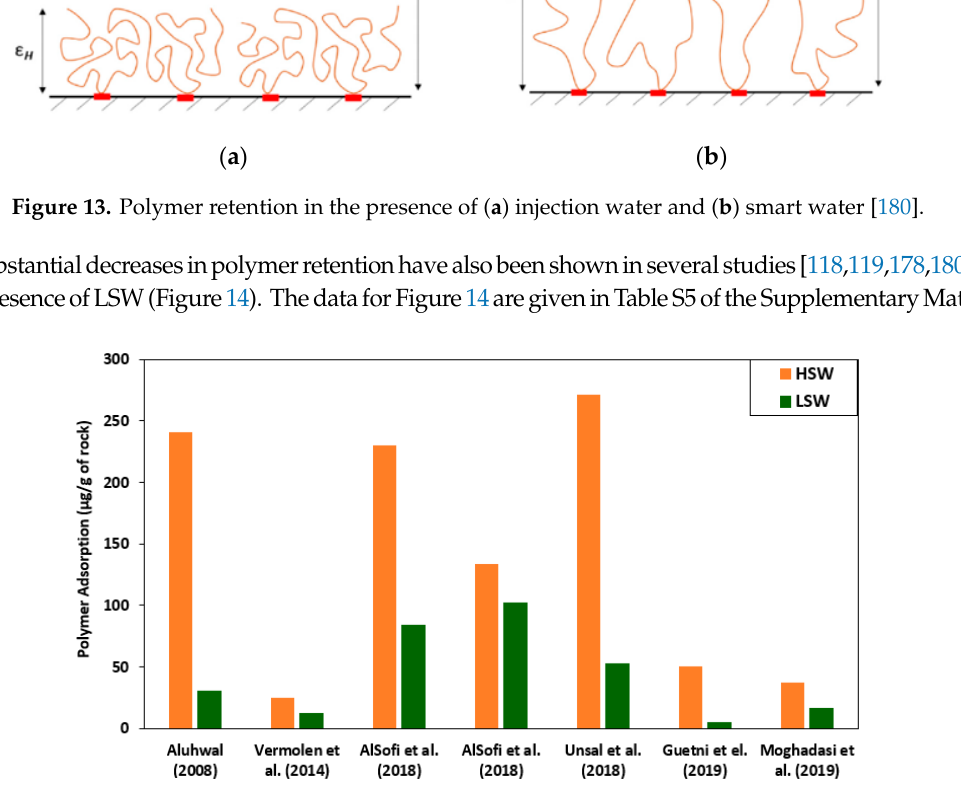
Figure 14. Studies showing reductions in the required polymer adsorption using LSW.